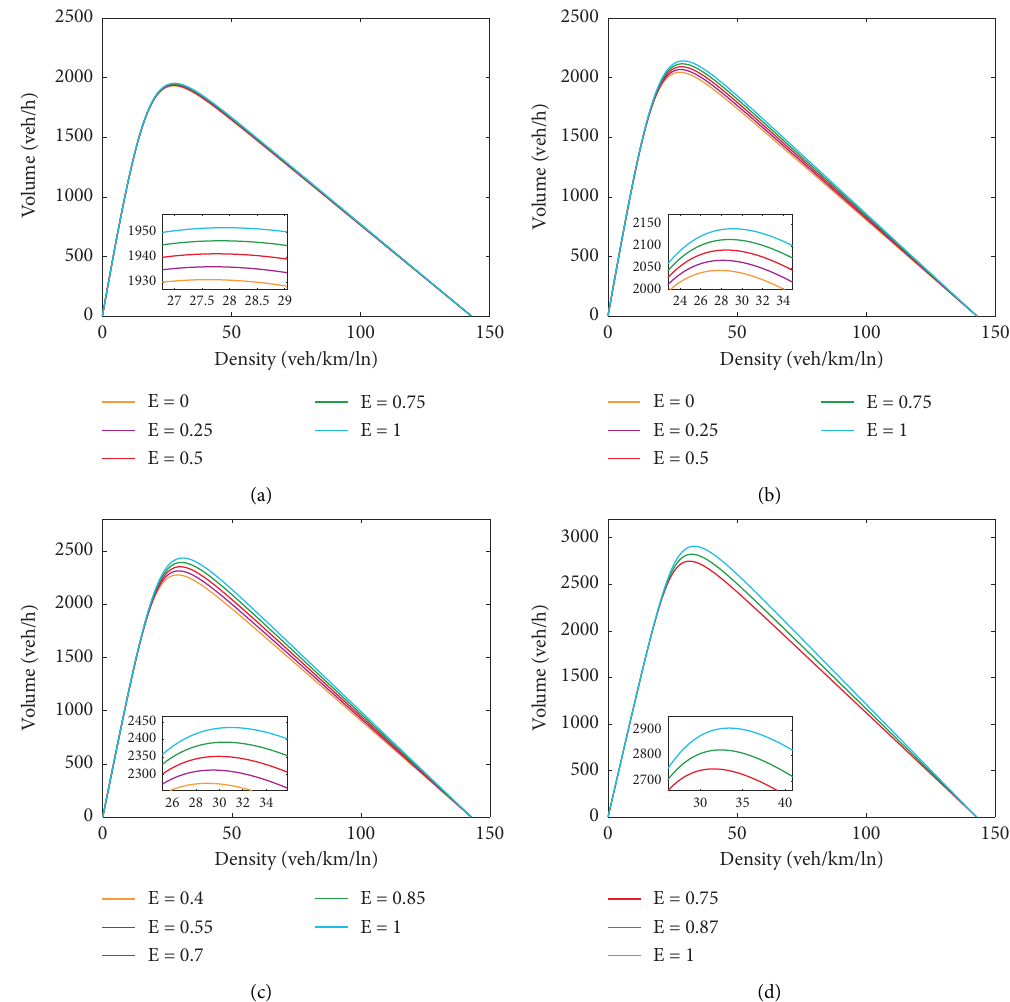
Figure 6: Flow-density fundamental diagrams under diferent CAV penetration rates: (a) p � 0 . 2, (b) p � 0 . 4, (c) p � 0 . 6, and (d) p � 0 . 8.